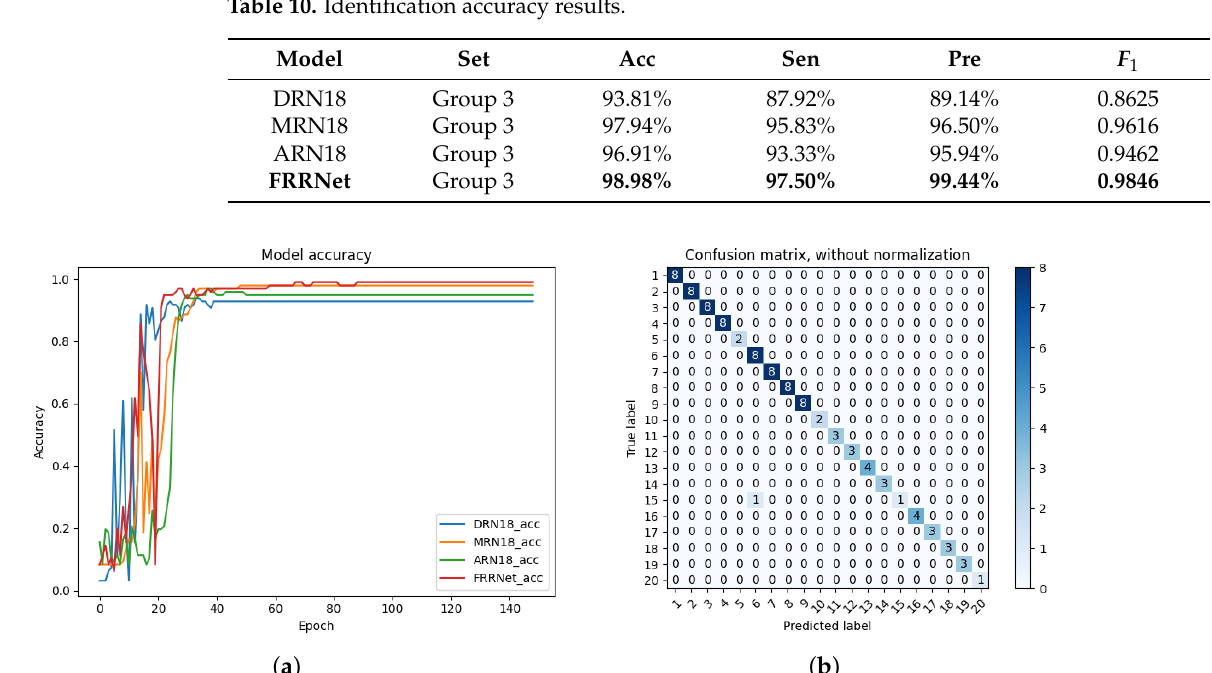
Figure 12. ( a ) Comparison of the recognition accuracy of network models; ( b ) Testing matrix of Group 3 of FRRNet (20